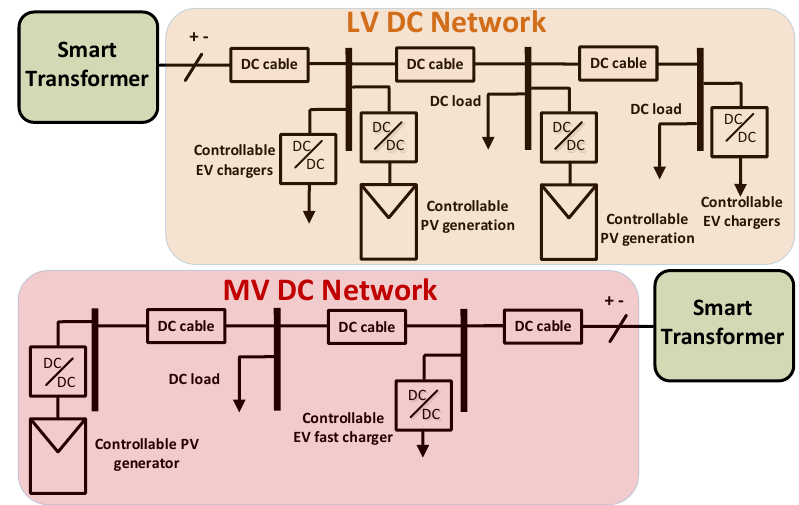
Figure 11. Computational models for the MV and LV DC